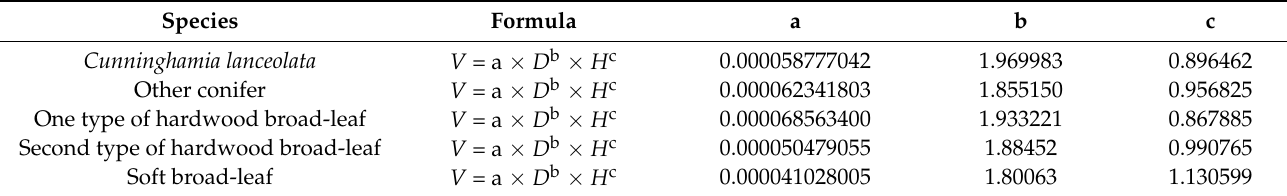
Table 2. Two-dimensional volume table of main trees.